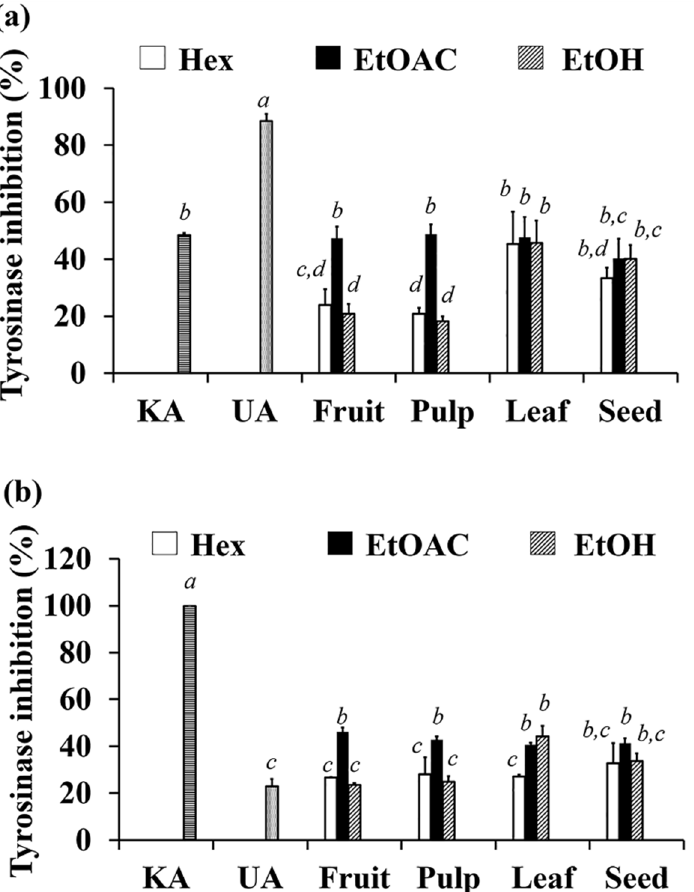
Figure 8. Inhibition against diphenolase ( a ) and monophenolase ( b ) activities of tyrosinase at concentration of 125 μ g/mL kojic acid (KA), ursolic acid (UA) and C. carandas extracts sequentially extracted using n -hexane (Hex), ethyl acetate (EtOAc), and 95% ethanol (EtOH), respectively. The letters a , b and c denote significant difference among different C. carandas extracts ( p < 0.05) after being analyzed by one-way ANOVA followed by Tukey’s test.